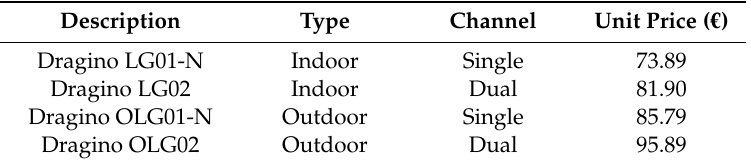
Table 4. LoRa gateway